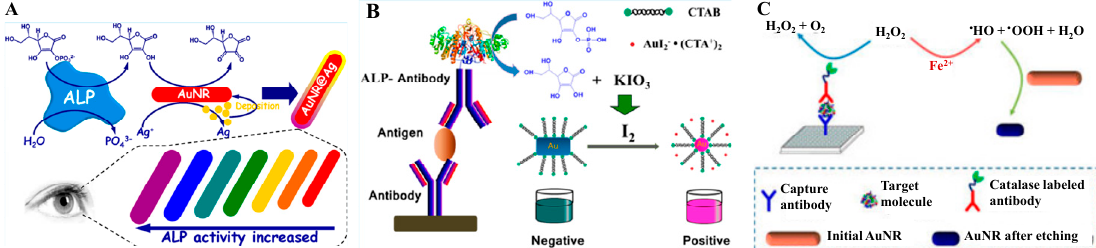
Figure 13. ( A ) Schematic illustration of the high-resolution colorimetric assay for sensitive visual readout of phosphatase activity based on gold/silver core/shell nanorod. Reproduced with permission from [142]. Copyright American Chemical Society, 2014. ( B ) Schematic illustration for visual plasmonic ELISA based on ALP-triggered etching of AuNRs. Reproduced with permission from [144]. Copyright American Chemical Society, 2015. ( C ) Principle of the proposed naked-eye semiquantitative ELISA for visual quantification of proteins. Reproduced with permission from [147]. Copyright American Chemical Society, 2015.